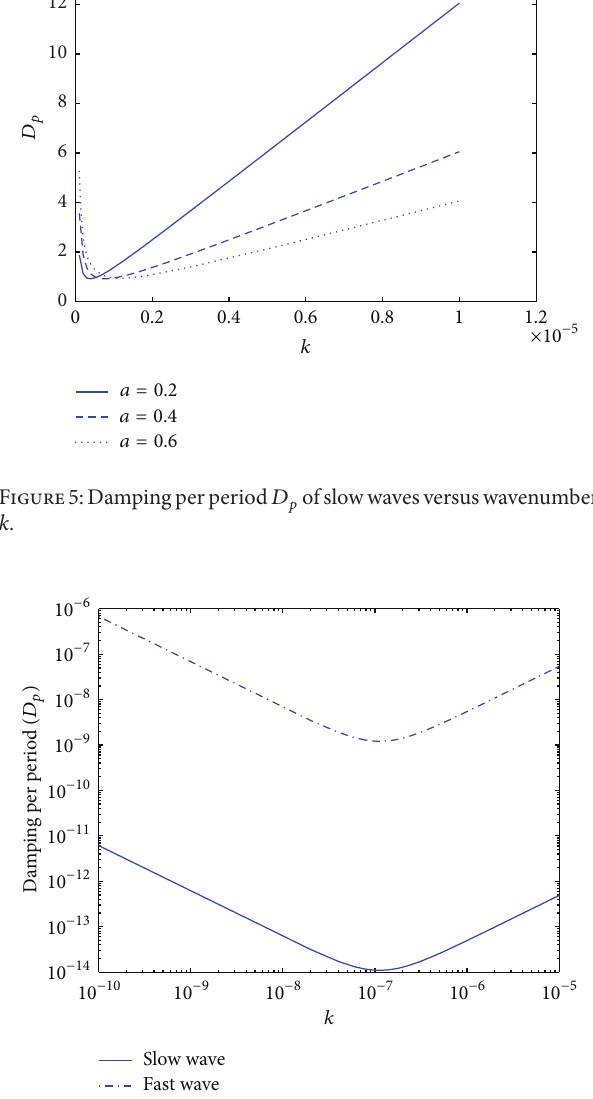
Figure 6: Damping per period 𝐷 𝑝 versus wavenumber k